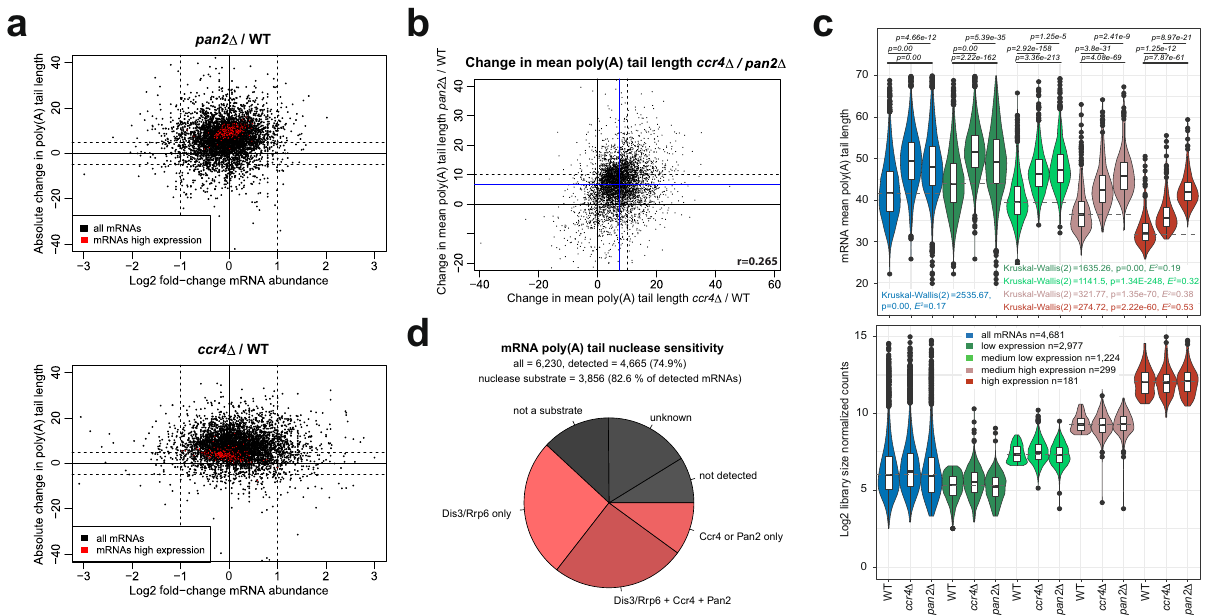
Fig. 5 PAN2/3 and CCR4-NOT cytoplasmic deadenylase complexes can target distinct sets of transcripts. a Relationship between log2 fold change in mRNA abundance and absolute change in mean poly(A) tail length for pan2 Δ (top) and ccr4 Δ (bottom) strains relative to WT. Dashed lines show a twofold change in expression and a 5-adenosine change of mean poly(A) tail length. b Relationship between absolute change in poly(A) tail length in ccr4 Δ cells relative to WT compared with an absolute change in poly(A) tail length relative to WT for pan2 Δ . Blue lines designate the mean poly(A) tail length change in each strain. Dashed lines mark a 10-adenosine change of mean poly(A) tail length. c The violin plot in the top panel shows the distribution of mean poly (A) tail lengths of detected mRNAs, binned by expression level in WT. The bottom panel shows log2-scaled mRNA abundance. The sum of counts from each mRNA category is indicated. Statistical signi fi cance for each expression group was calculated using the Kruskal – Wallis test P value and Holm- corrected P values for the two-sided Dunn pairwise test. Box plots show median value (solid bold line) and 1st and 3rd quartiles, whiskers represent 1.5 × IQR (interquartile range). Outliers are marked as black points. d Pie chart showing in red the fraction of cellular mRNAs that were deadenylated by only the exosome (1643), only CCR4-NOT and/or PAN2/3 (625), or all three complexes (1588). Out of a total of 6230 annotated mRNAs, 4665 were reproducibly detected. Transcripts that were unaffected or could not be detected by DRS are highlighted in